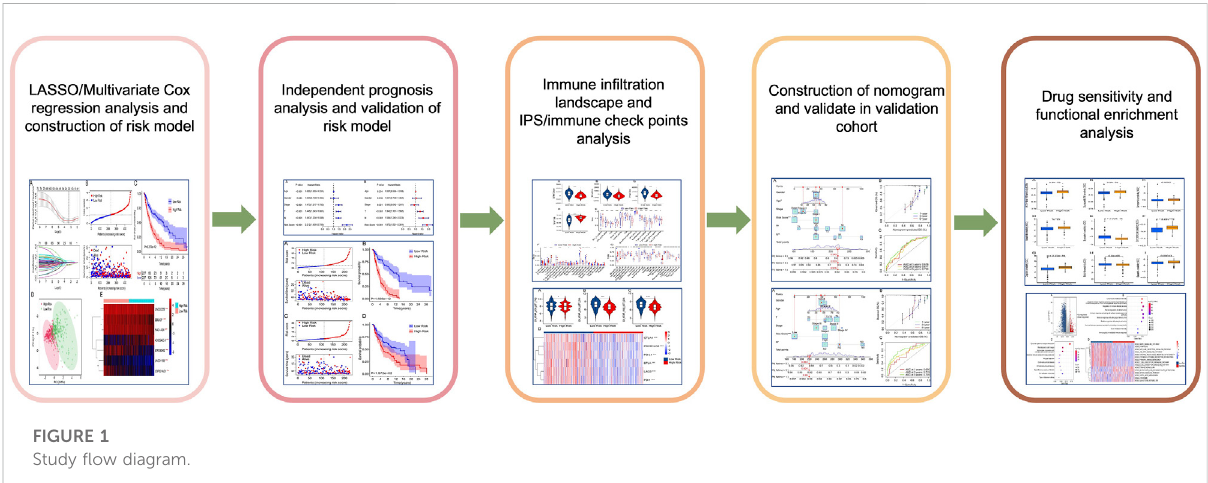
FIGURE 1 Study fl ow